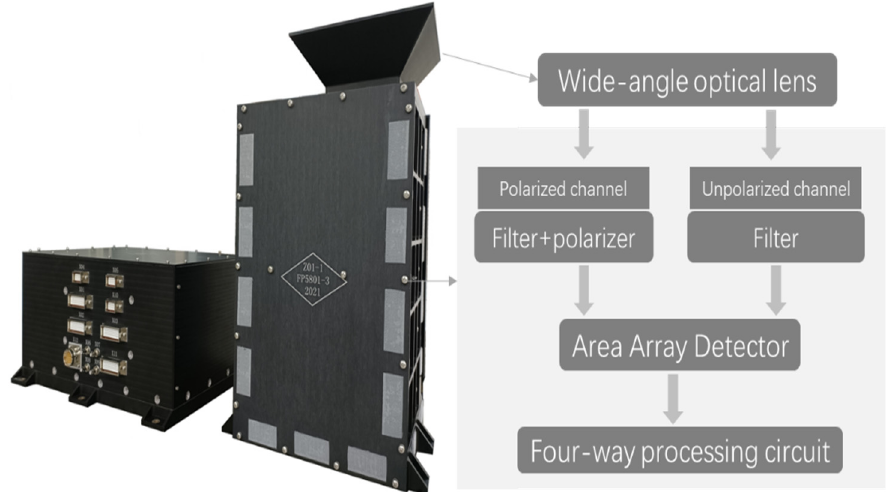
Figure 1. Picture of MAPI prototype and main component description.